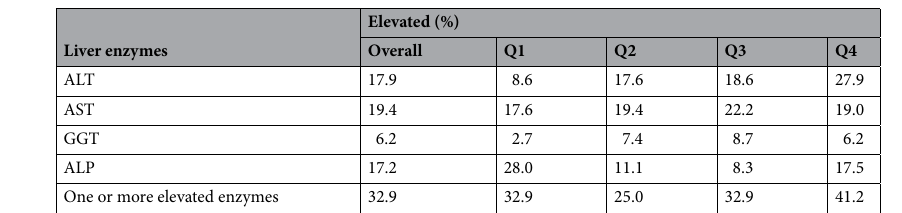
Table 2. Prevalence of elevated liver enzymes across the SUA quartiles. Elevated liver enzymes were defined on the basis of recommended cutoffs as a serum ALT level > 45 U/L for men and > 34 U/L for women, AST level > 35 U/L for men and > 31 U/L for women, GGT level > 55 U/L for men and > 38 U/L for women and ALP level > 128 U/L for men and > 98 U/L for women 29–31